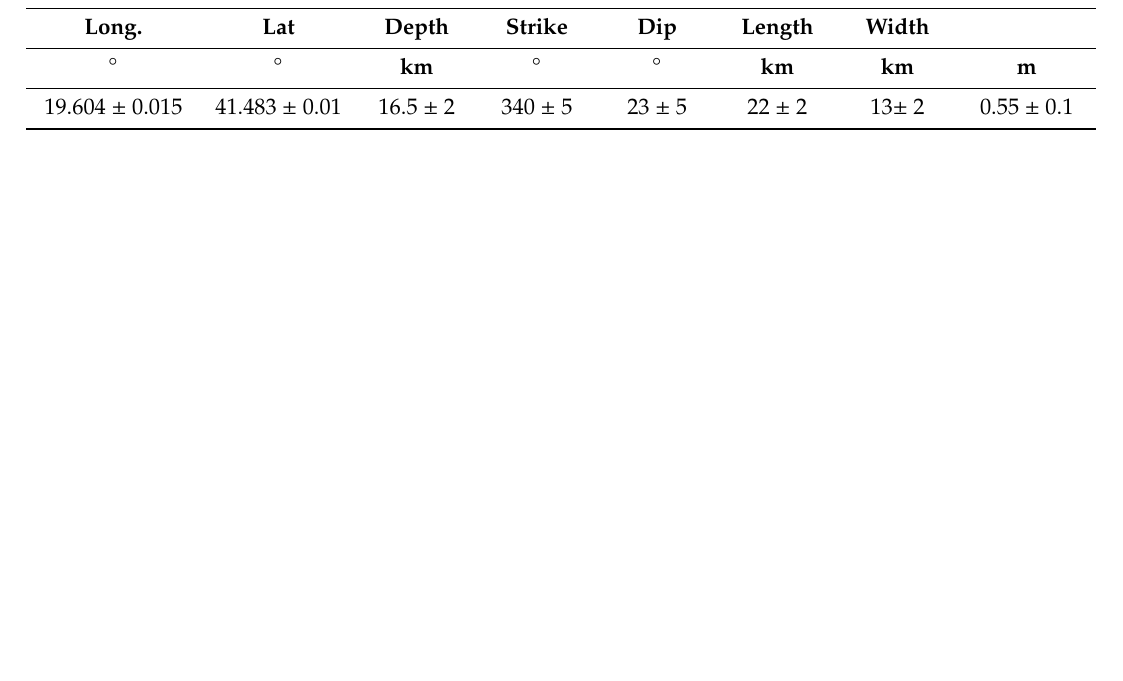
Table 4. Parameters of the seismic fault as determined by linear inversion of geodetic data. Centroid refers to centre of the fault plane (yellow star in Figures 2 and 5).